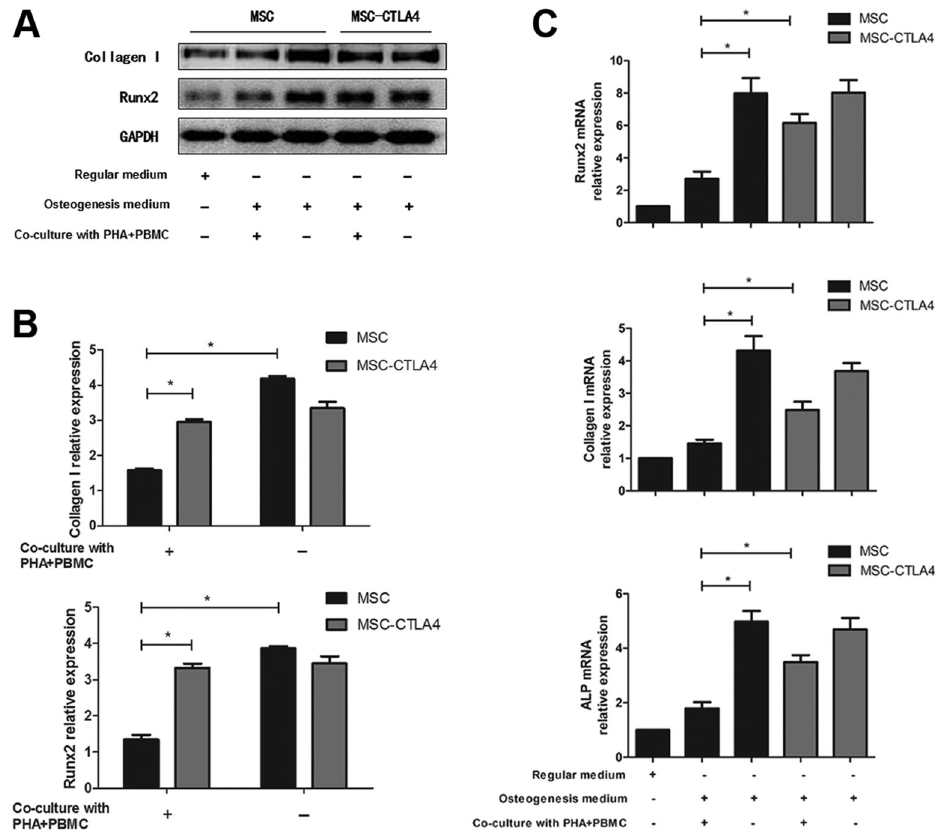
Figure 3. Protein levels and mRNA expression of Runx2, collagen 1 and alkaline phosphatase (ALP). Activated peripheral blood mononuclear cells (PBMCs) were co-cultured with mesenchymal stem cells (MSC) or MSC-CTLA4 at a ratio of 5:1 for 2 h in fl at-bottom 96-well plates, after which culture medium was replaced with osteogenic medium and incubated for 21 days. A and B , Protein levels of Runx2 and collagen 1 after 9 days of culture in osteogenic medium. C , mRNA expression levels of Runx2, collagen 1 and ALP after 9 days of osteo-induced cultivation. Data are reported as means ± SD. *P o 0.05 (Student ’ s t